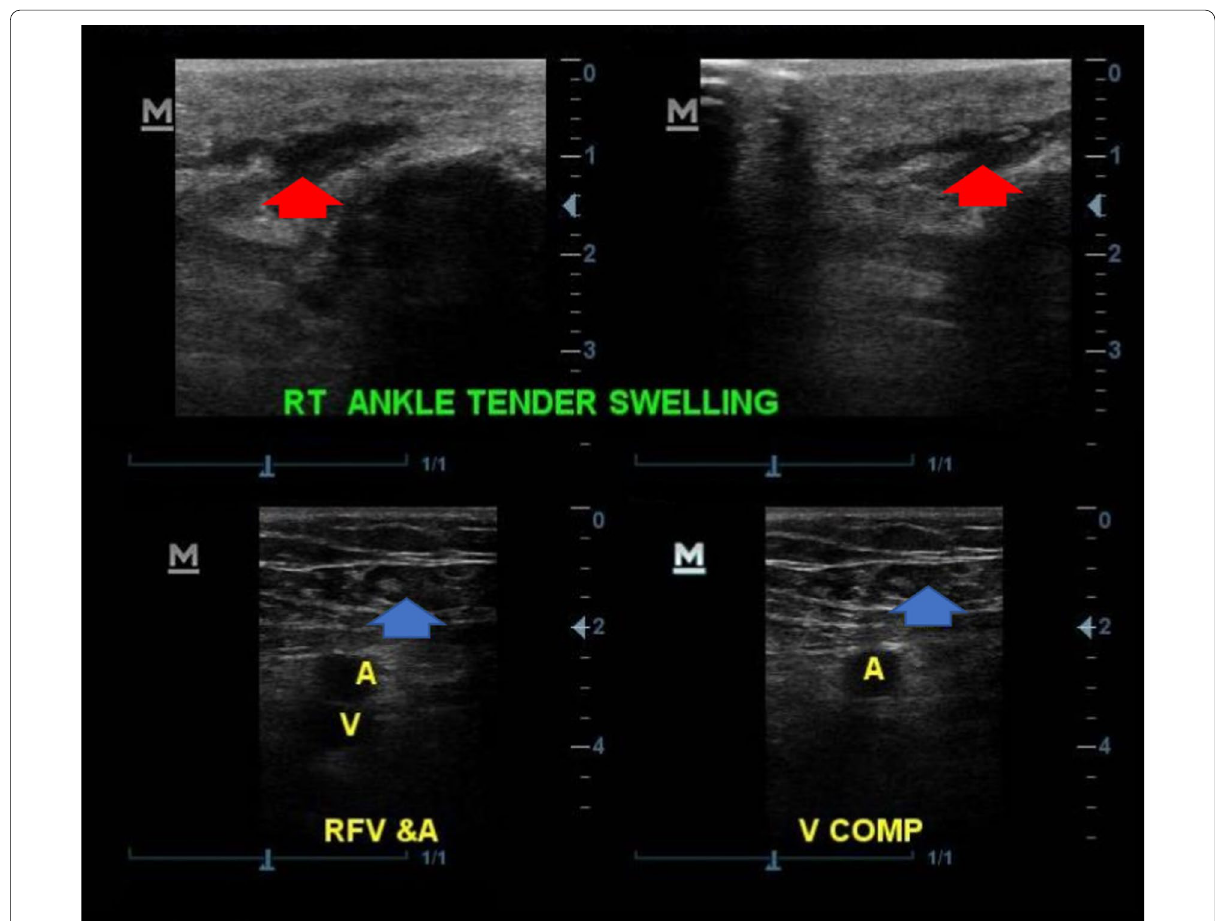
Fig. 8 Sonographic images of the right lower limb performed for a 47‑year‑old male with diabetes, who reported with a two‑day history of swelling of the right lower limb (worst at the ankle) and fever of three‑day duration. The demonstrated deep femoral veins are normal. It shows hypoechoic fluid collection in the subcutaneous layer of the right ankle as indicated with the red arrows and associated multiple inguinal lymphadenopathies (blue arrows) ultimately diagnosed as cellulitis